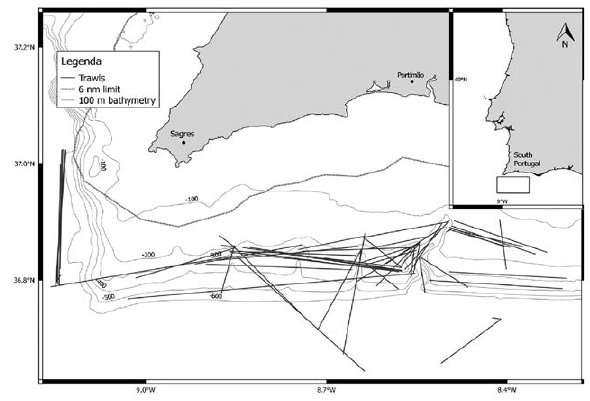
Fig. 1. – Location of the study area off South Portugal (Algarve) where the trawls were performed (dark grey lines). The dashed line represents the 6 minimum nautical mile limit of fishing for trawlers. The light grey lines represent the bathymetry every 100 m depth.